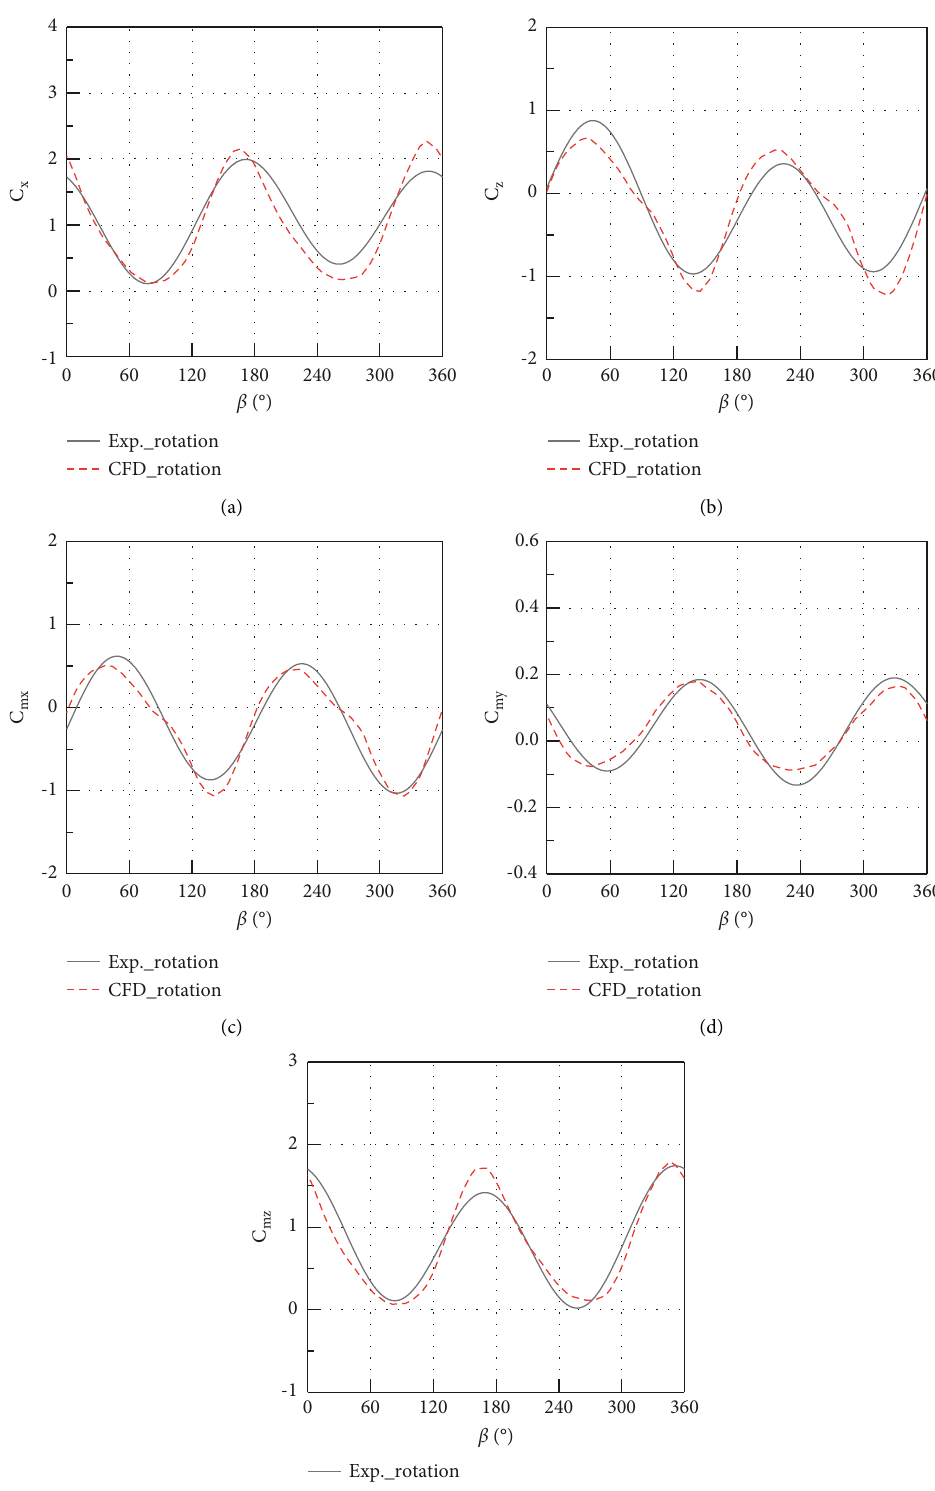
Figure 4: Comparison between test results and simulation results of antenna dynamic aerodynamic coefficient: (a) C (c) C mx – β , (d) C my – β , and (e) C mz – β